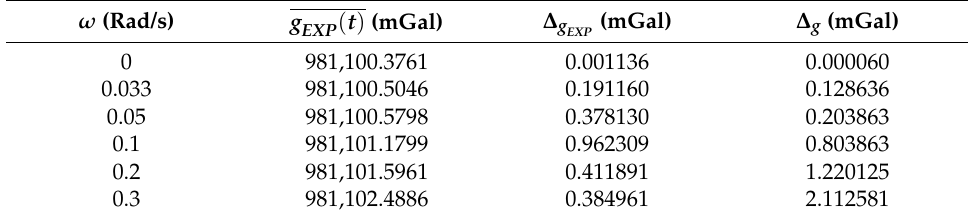
Table 5. SE errors caused by resonant